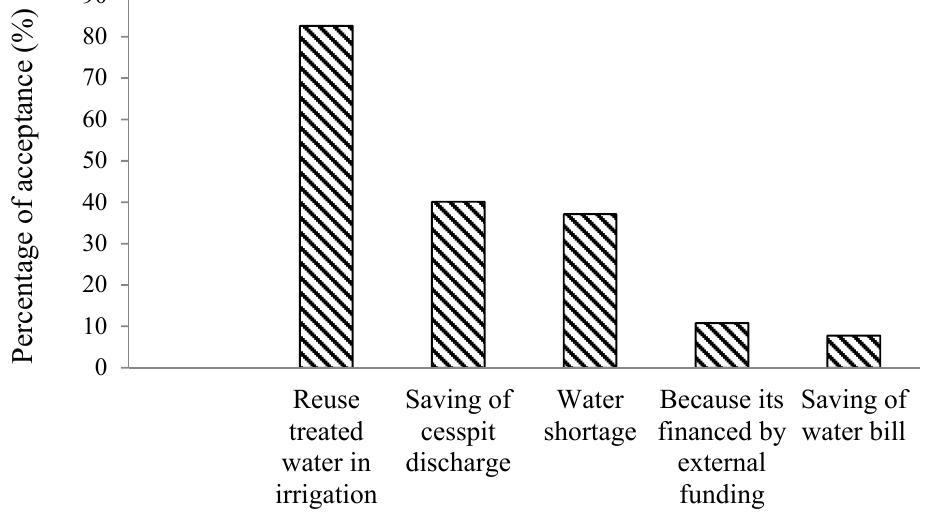
Figure 7. Percentage of beneficiaries’ acceptance of GWTPs based on influencing factors.